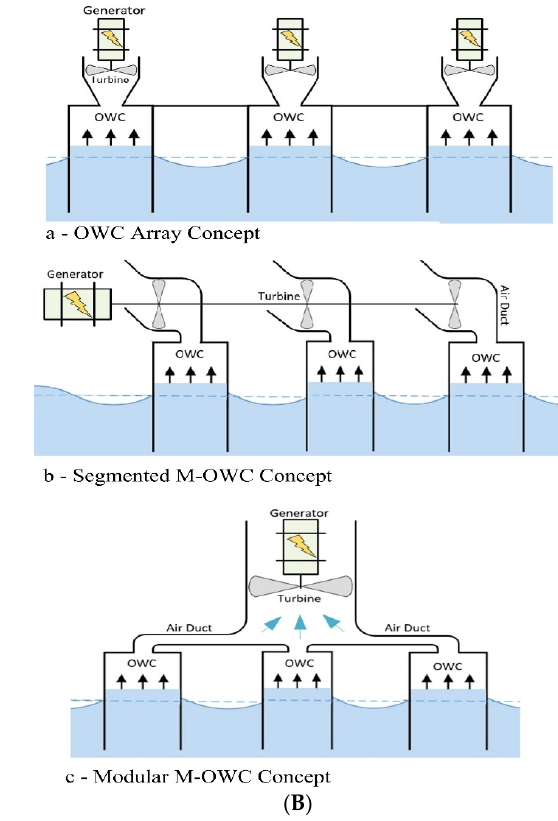
Figure 7. Electricity generation employing OCW: ( A ) Working principle of the point absorber (authors’ own illustration) and ( B ) multi OCWs with different configurations (adopted from [90] with license no. 5240610225589). Table 3. Running demonstration projects for OBC in several